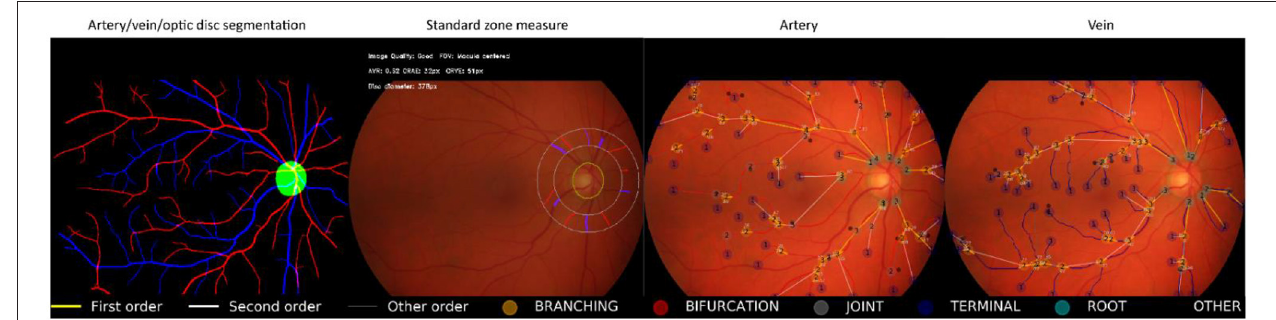
FIGURE 4 | Illustration of Retina-based Microvascular Health Assessment System (RMHAS) output. From left to right: artery, vein, and optic disc segmentation; parameters measured in the standard zone; parameters measured in the whole fundus for artery and vein, respectively. Measures are demonstrated and plotted visually. Users can examine the performance of each functional part throughout the analysis.